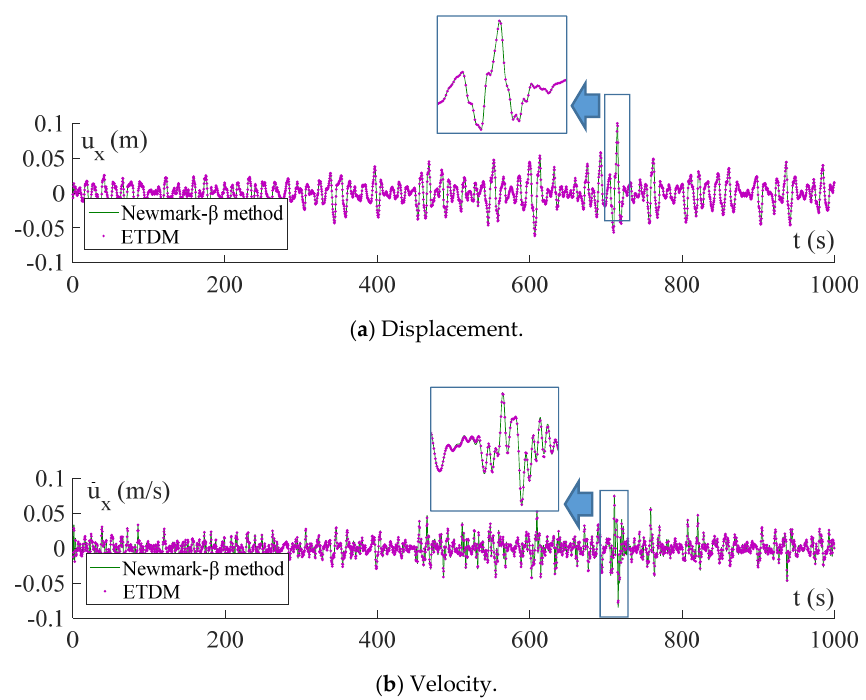
Figure 9. Displacement and velocity at a top node of the jacket platform.